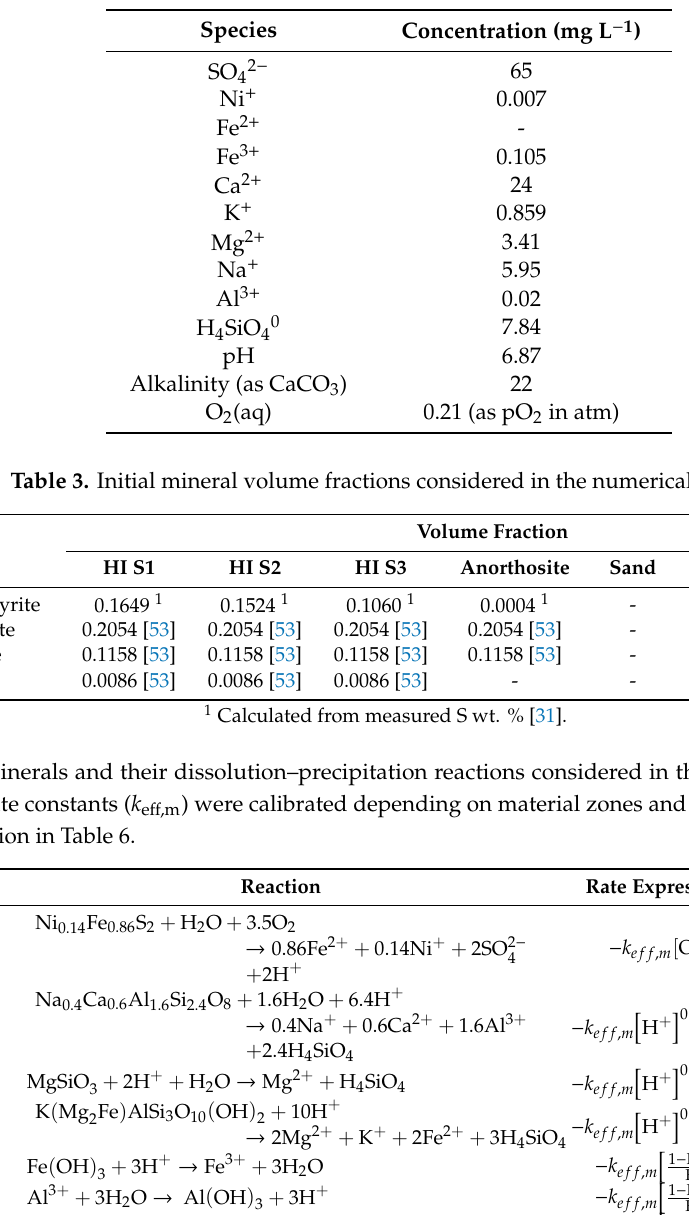
Table 2. Composition of the infiltrating water applied to the model.